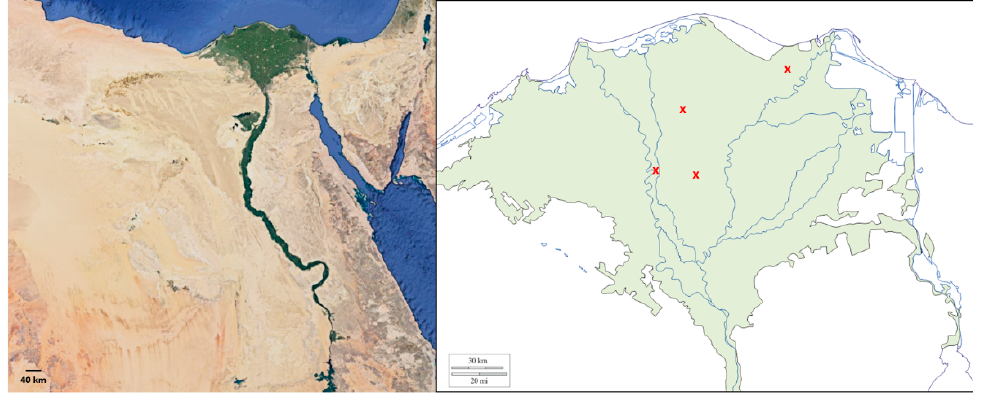
Figure 1. The map of Egypt to the left (Google Earth, accessed on 1 May 2021. 26°41 ′ 46 ″ N 30°47 ′ 53 ″ E) shows the green narrow strip of the Nile Valley and its Delta as the vital food basket for Egypt’s 100-million population. The (×) signs on the map of Nile Delta to the right (https://d-maps.com, accessed on 1 May 2021) indicate approximate soil sampling regions.